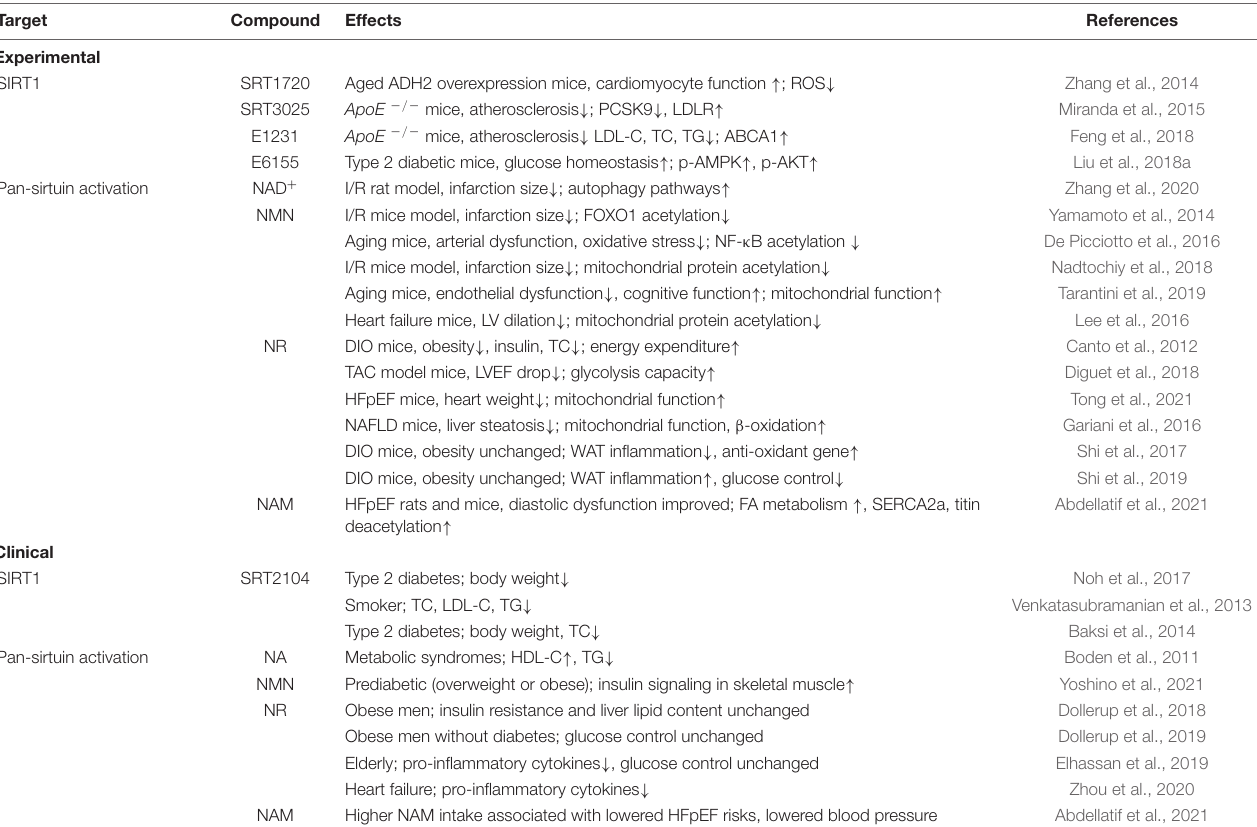
TABLE 1 | Pharmacological intervention of sirtuin activity and their effects on cardiovascular risk factors and